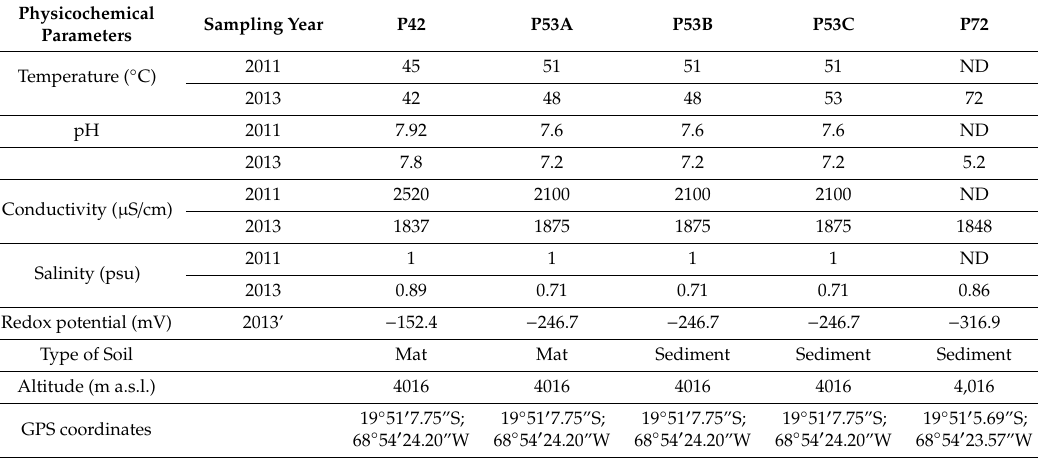
Figure 1. Lirima hydrothermal system. Map of Chile that displays the location of the Lirima hydrothermal system and the spatial distribution of the hot springs (P42, P53A, P53B, P53C, and P72). Table 1. Physicochemical parameters of the Lirima hot springs.